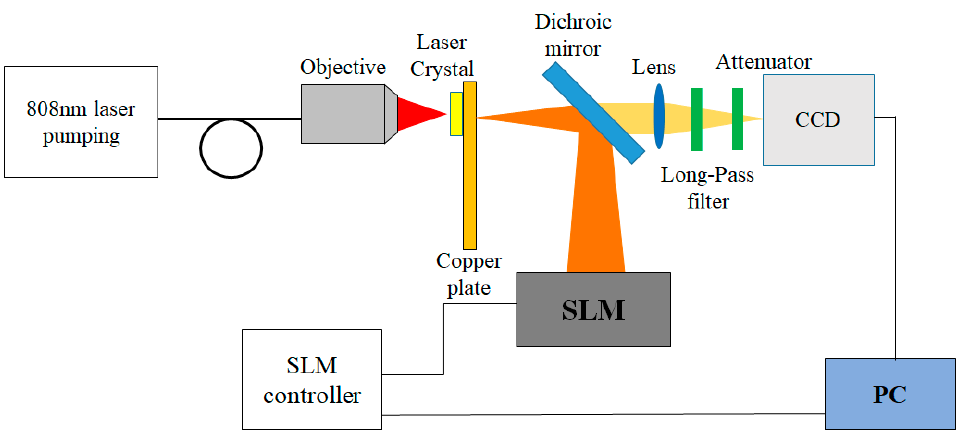
Figure 1. Experiment setup. The incident surface of the laser crystal, the 45-degree-tilted dichroic mirror, and the reflective panel of the SLM formed a folded L-shaped laser cavity. The dichroic mirror was the output coupling mirror of the laser system. The output laser beam passed through the lens, a long pass filter, and an attenuator, and was then observed on the CCD.